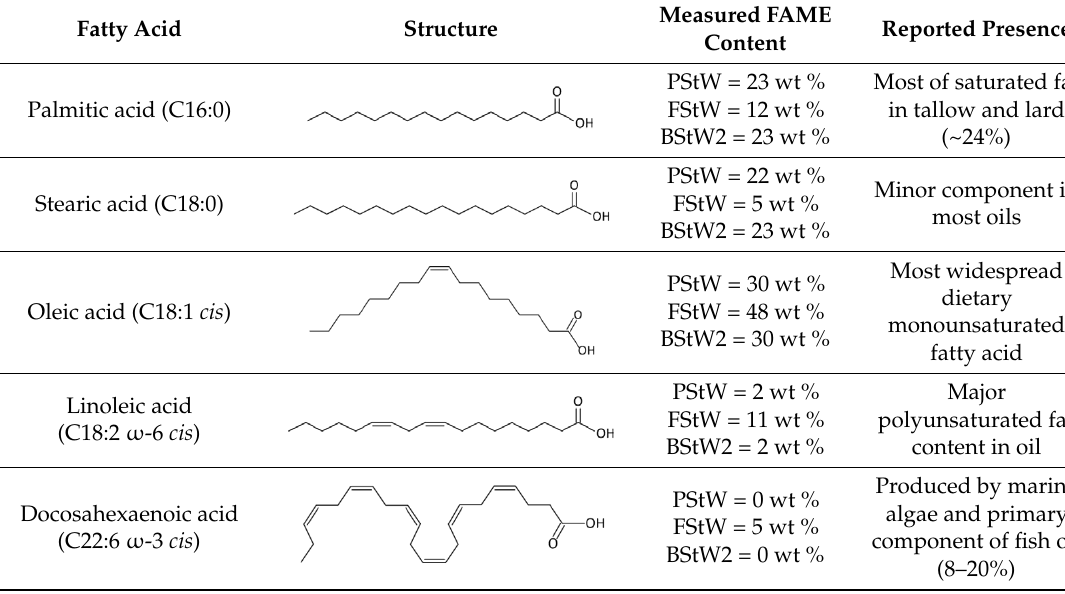
Figure 1. Fatty acid methyl ester (FAME) analysis result showing the weight proportion of the key fatty acid groups present in the fats from the MD stick water feed samples shown in Table 2 (PStW, FStW and BStW2). The full set of FAME analysis results are presented in Figure S1 of the Supplementary Material. Table 2. Summary of fatty acids detected by FAME and reported presence in animal fats. Structure and reported presence details from literature [34].